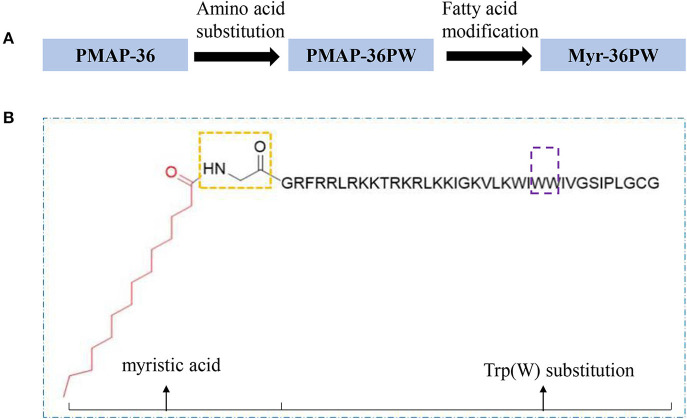
Peptides timeline and Myr-36PW molecular structure. (A) The timeline of peptide design from PMAP-36 to PMAP-36PW to Myr-36PW. (B) Myr-36PW molecular structure. The red structure indicates myristic acid, the yellow frame indicates an amide bond containing a Gly linker, the sequence represents PMAP-36PW, and the purple frame indicates Trp(W) substitution at positions 25 and 26 of PMAP-36. Myristic acid was tethered to N-terminal PMAP-36PW via the amide bond containing a Gly residue to form Myr-36PW.